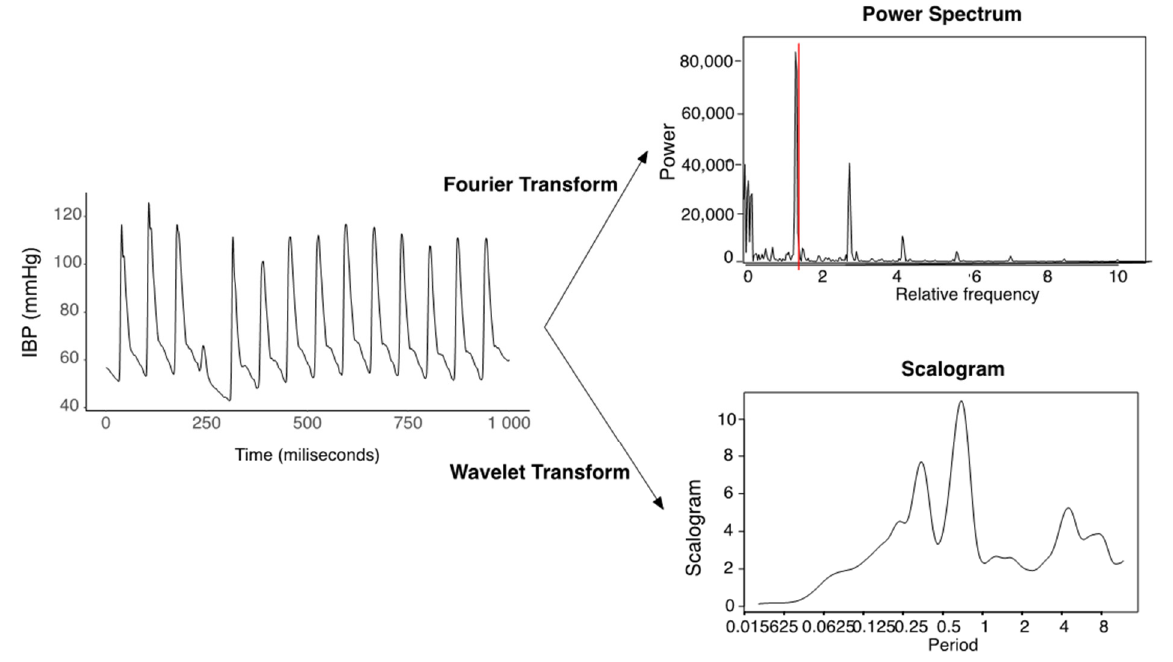
Figure 5. Fourier transform and wavelet transformation of the time domain signal. Table 2. Details of the feature